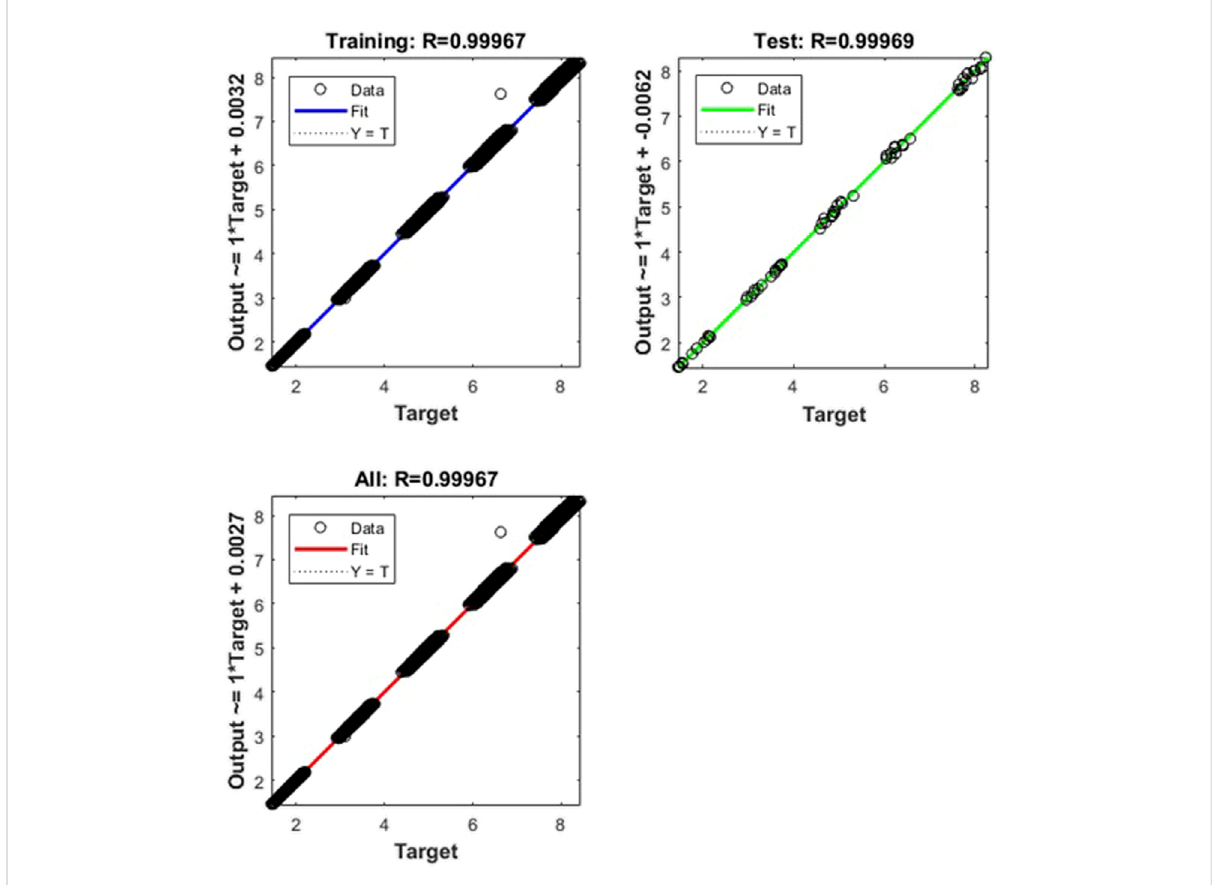
FIGURE 12 Plot for regression analysis.